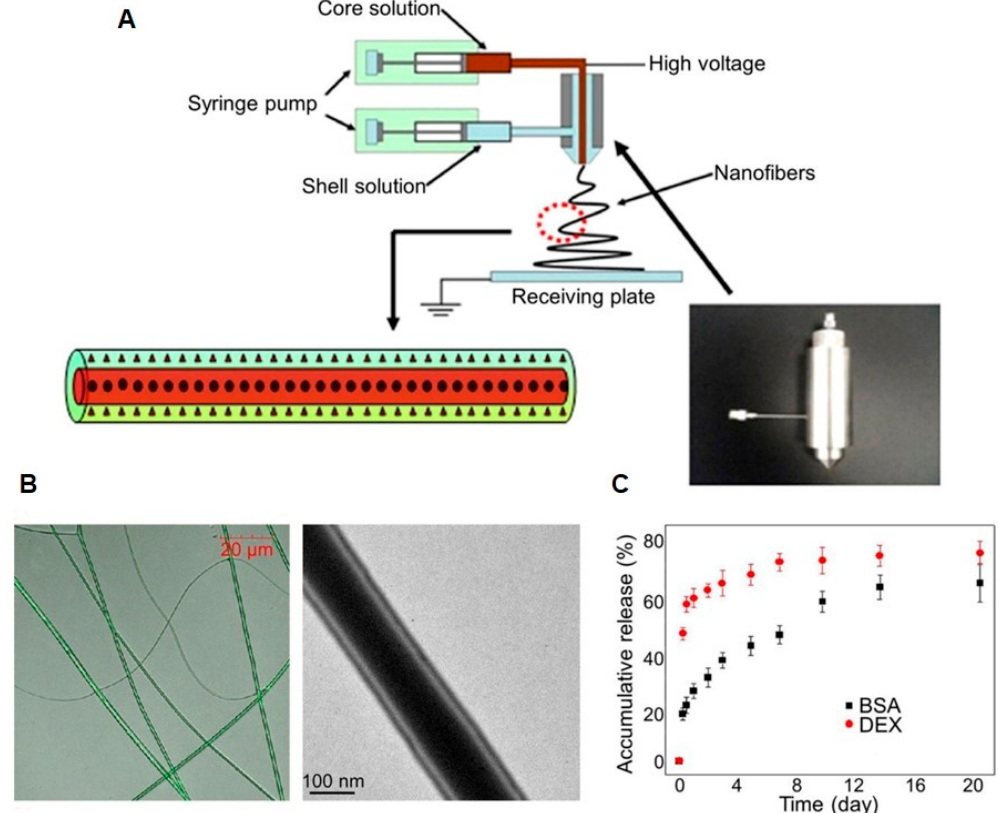
Figure 6. Preparation and characterization of dexamethasone (DEX) and bone morphogenetic protein-2 (BMP-2) co-loaded emulsion electrospun nanofibers and their effects on human mesenchymal stem cells (hMSCs). ( A ) Preparation of poly( L -lactide- co -caprolactone) (PLLACL) emulsion electrospun nanofibers with DEX in the shell and BMP-2 in the core. ( B ) Fluorescence microscopic image and transmission electron microscopy (TEM) image of the nanofibers. ( C ) Release profiles of bovine serum albumin (BSA) and DEX from the nanofibers. Reproduced from [180] with permission from Elsevier Ltd.; Copyright 2012.